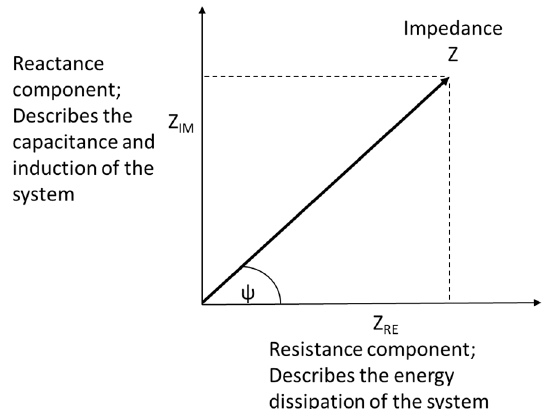
Figure 3. Phasor diagram relating the Cartesian and polar coordinates of impedance in the complex plane.